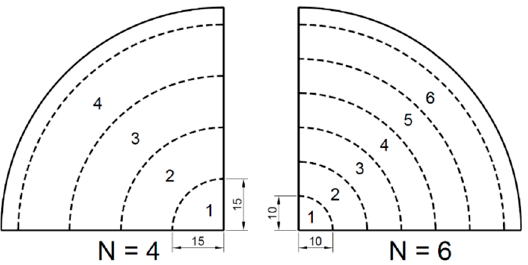
Figure 2. Zone divisions of poly (l-lactic acid) (PLA) sheets for thermal optimisation.